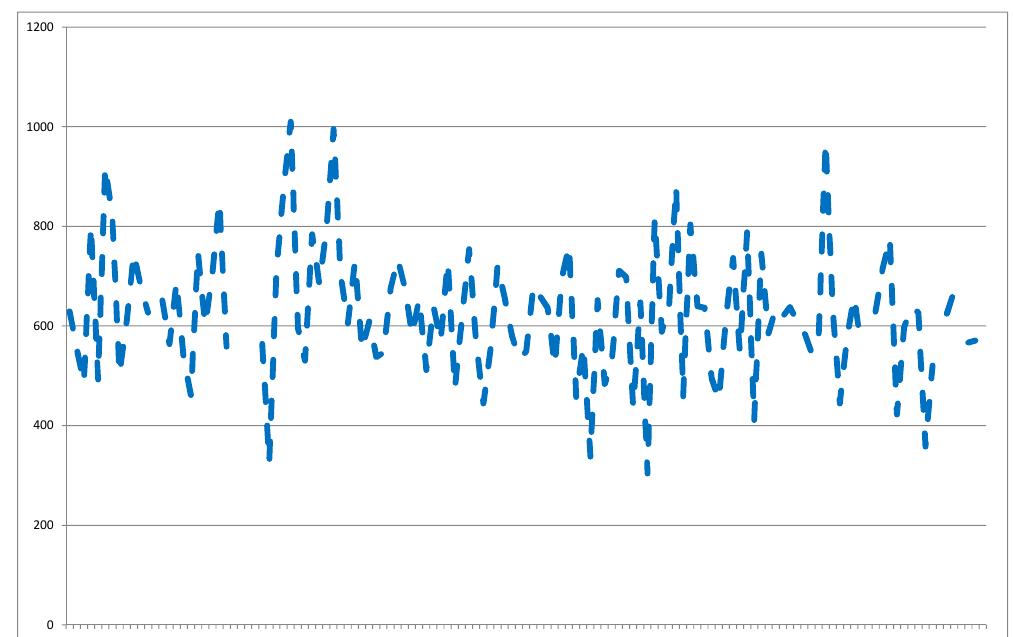
Figure 11. Annual rainfall totals for Glen Osmond, 34 . 95 ◦ S, 138 . 65 ◦ E, for 1884–2013. Note that exponential smoothing was not done for this location as there are some missing